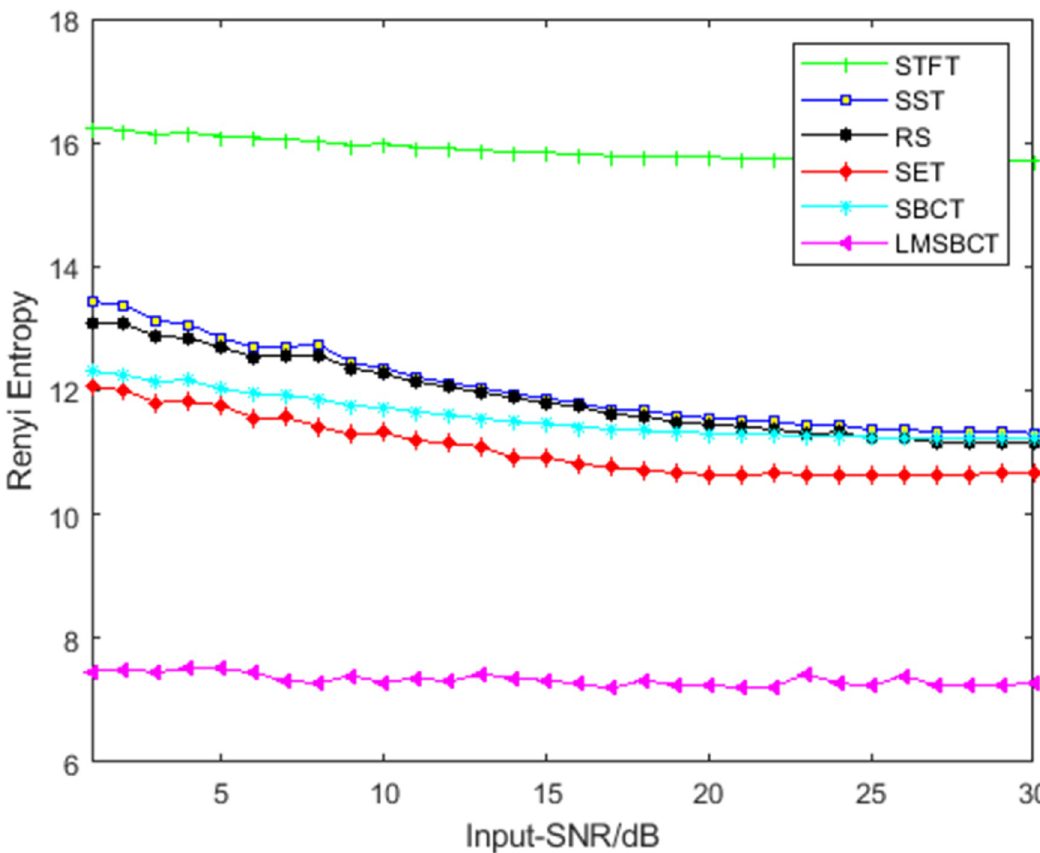
Fig 7. Plots of the Re´nyi entropy vs SNR for various TFA methods.